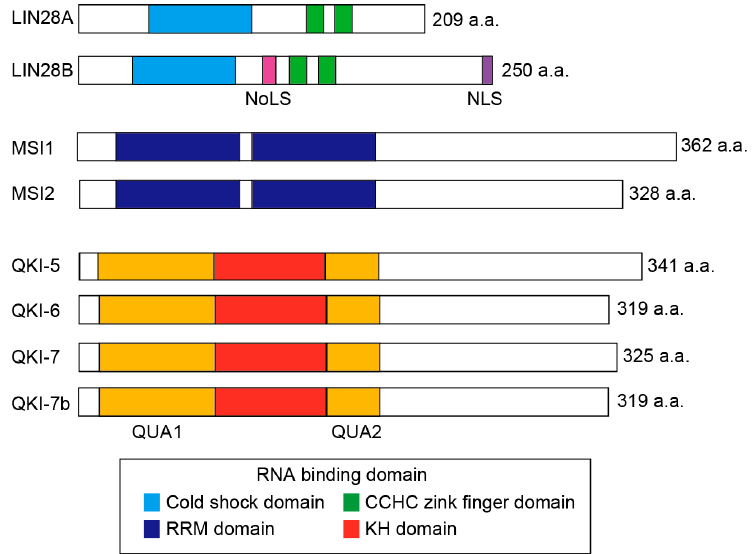
Figure 3. Domain structures of the RBPs. Schematics illustration of the three RBPs, LIN28A/B, MSI1/2, and QKI-5/6/7/7b. LIN28A/B have two types of the RNA-binding domains, a cold shock domain (CSD) and Cys-Cys-His-Cys (CCHC) zinc finger domains. MSI1/2 have two RNA recognition motif (RRM) domains. QKI-5/6/7/7b have an RNA binding domain, KH domain which is flanked by QUA1 and QUA2 regions. The structure of QKI proteins differ at their C-terminal. NLS, a nuclear localization signal; NoLS, a nucleolar localization signal.